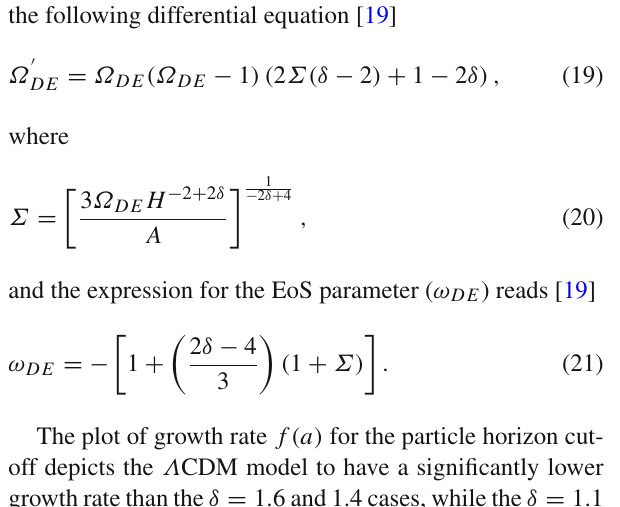
z DE (cid:7) 0 . 53. For the THDE model, this dissipation, as usual,